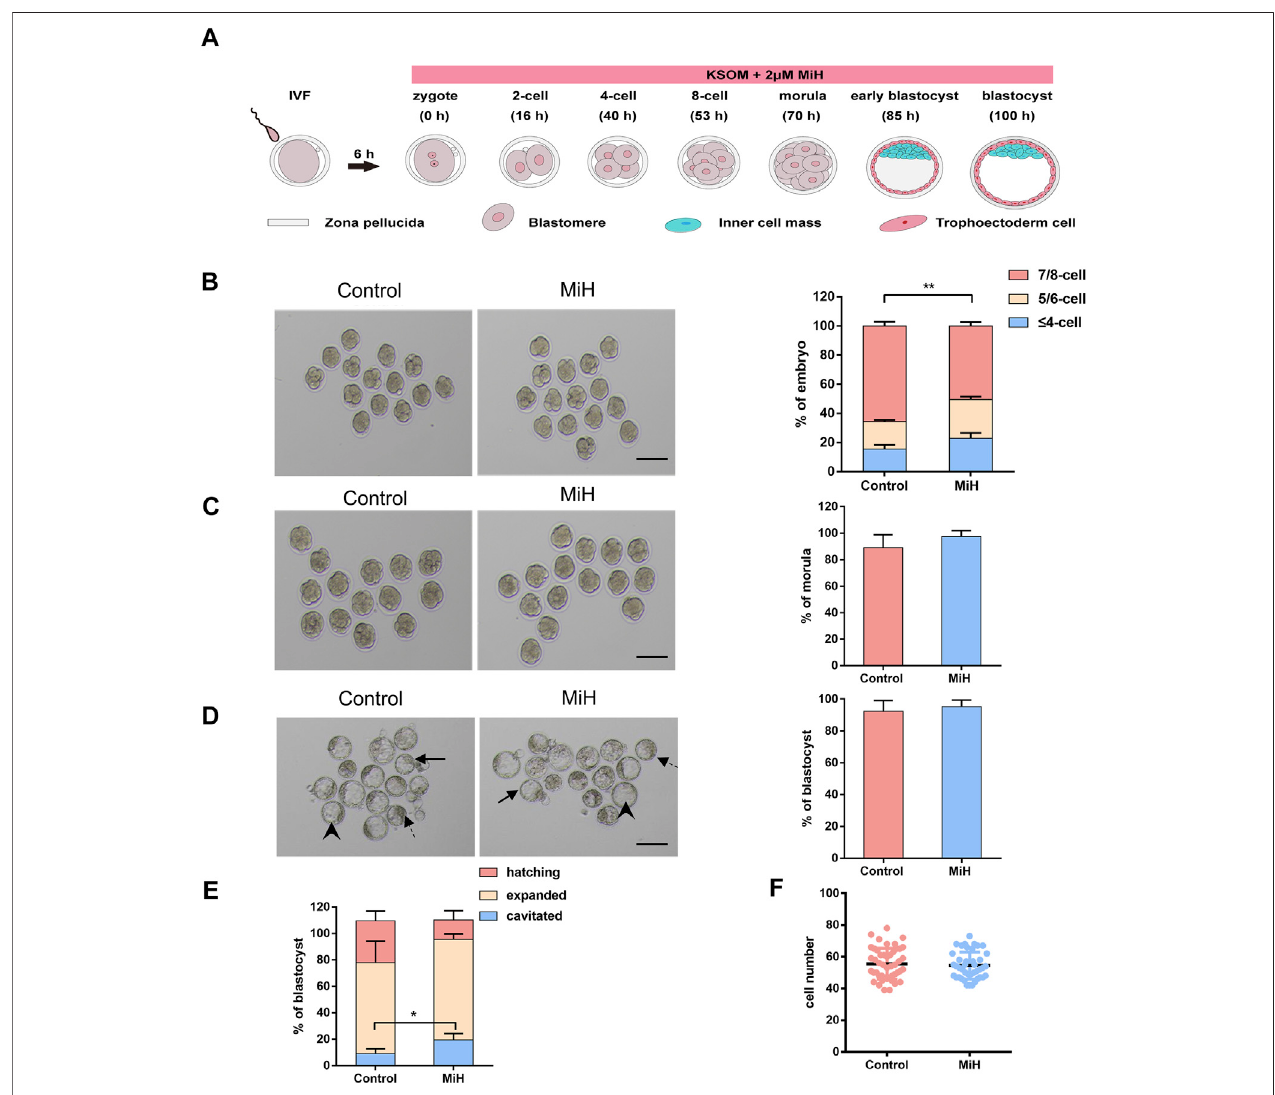
FIGURE 1 | MiH-treated embryos developed slower during cleavage stage but formed blastocyst normally. (A) Time scheme of in vitro fertilization (IVF) and main procedure of MiH treatment assay of mouse embryos. (B – D) Representative images and frequencies of embryos observed at 53 h (B) , 70 h (C) and 100 h (D) after fertilization in control ( n (cid:1) 65) and MiH-treated ( n (cid:1) 60) groups. Bar (cid:1) 100 μ m. (E) Quantitative analysis of cavitied, expanded and hatching blastocysts at 100 h. Dotted arrow,arrowheadsandarrowsindicatedthecavitied,expandedandhatchingblastocystsrespectively. (F) Cellnumberofeachexpandedorhatchingblastocystat 100 h.Dataarepresentedasmean ± SDinthreeindependentexperimentsandstudent ’ sttestsareusedforstatisticalanalysis. p 0.01 < p < 0.05; pp p < 0.01;nolabeling indicates no statistical signi fi